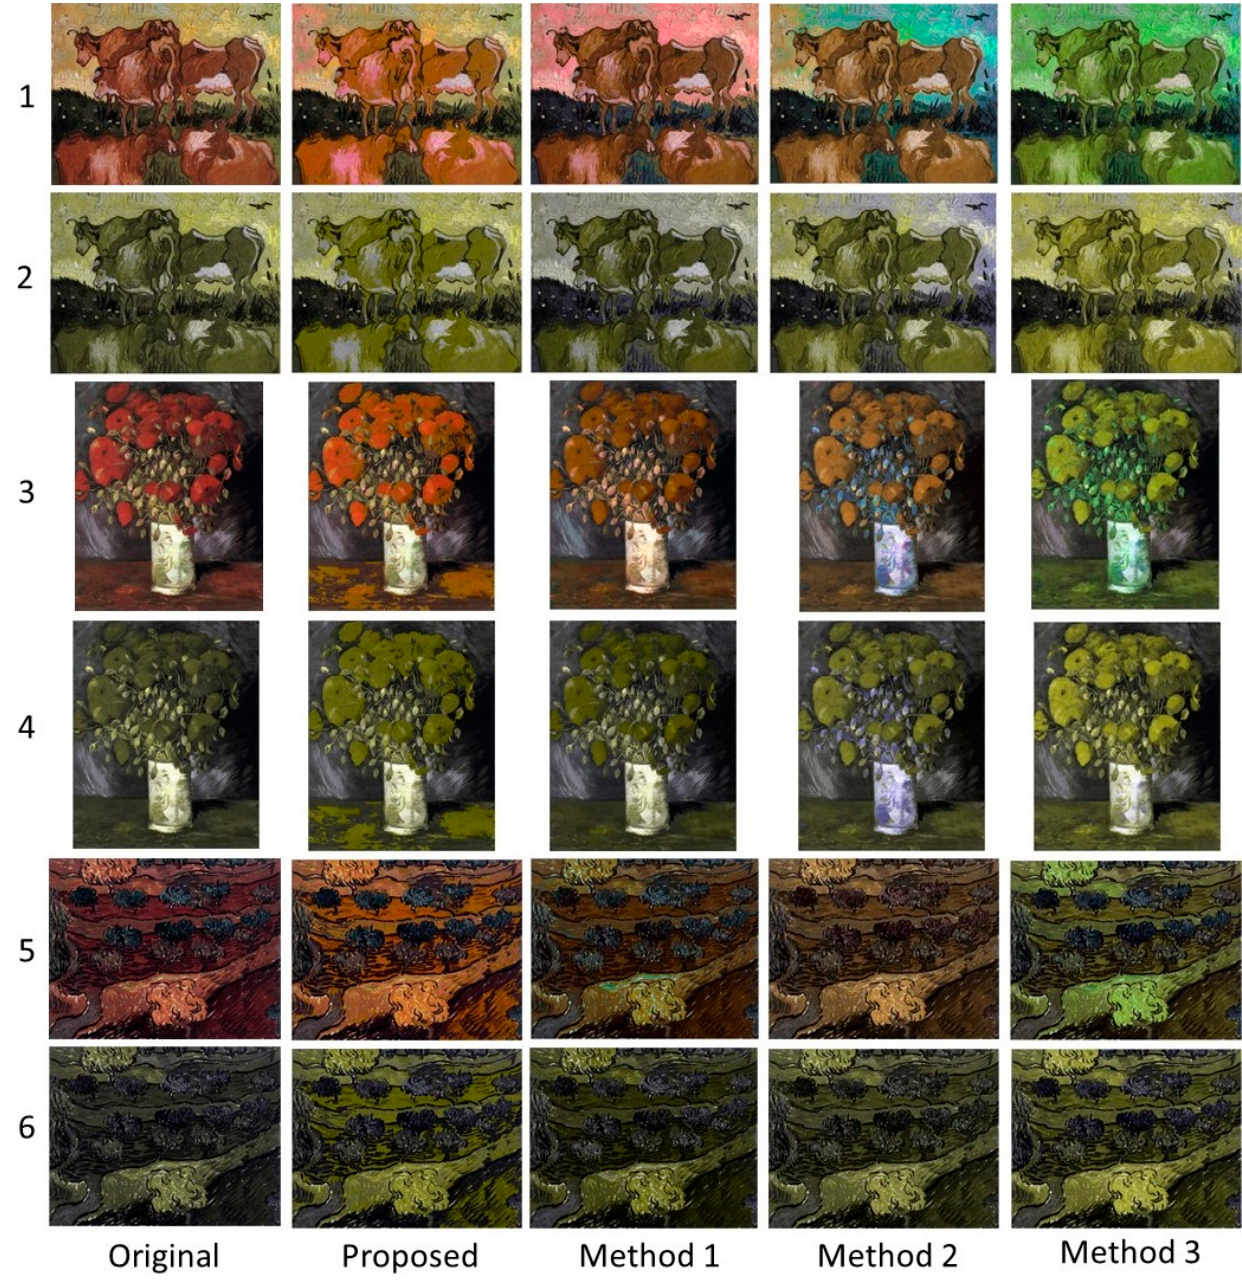
Figure 9. Qualitative comparison for protanopia using Paintings ( 1 , 3 , and 4 ). The original and the recolored paintings are given in rows ( 1 , 3 , and 5 ), while their respective protanope simulations are given in rows ( 2 , 4 , and 6